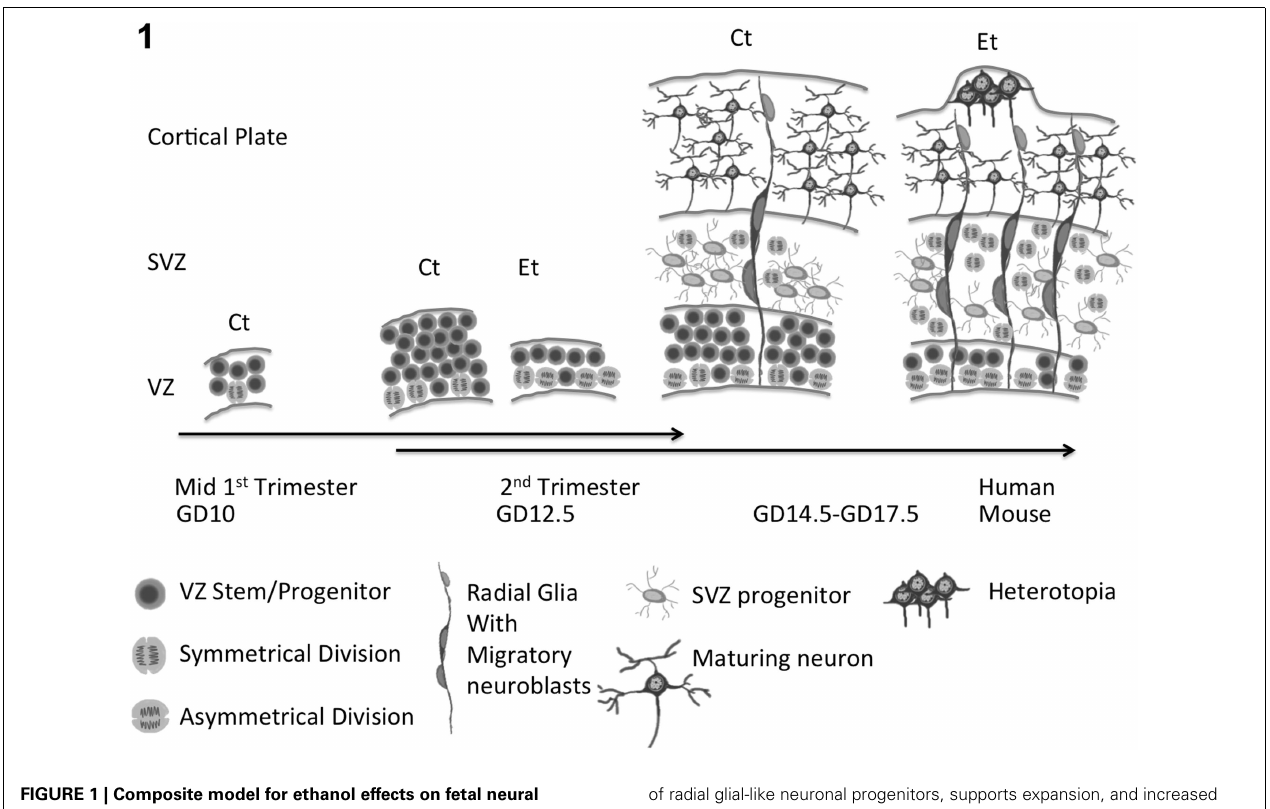
FIGURE 1 | Composite model for ethanol effects on fetal neural development. Ethanol promotes asymmetric neural stem cell (NSC) proliferation, leading to premature depletion of NSCs in the ventricular zone (VZ) and ultimately loss of reserve neuron generation capacity.The appearance